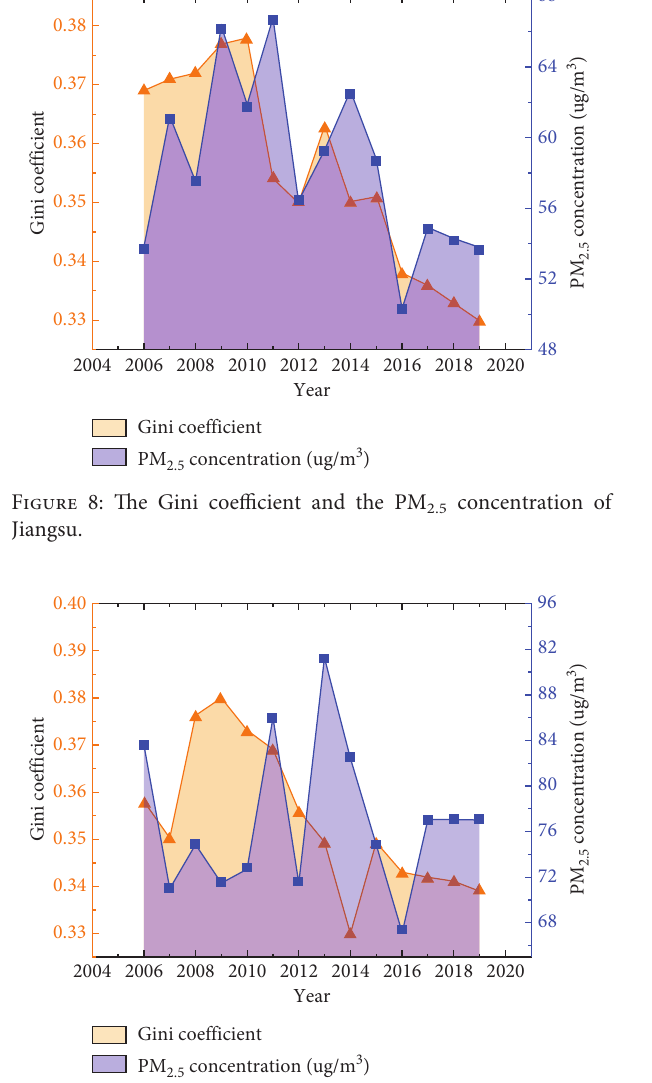
2.5 concentration of